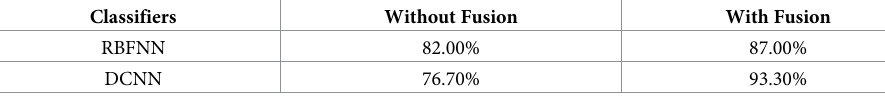
Table 8. Performance comparison between RBFNN and DCNN in leaf disease